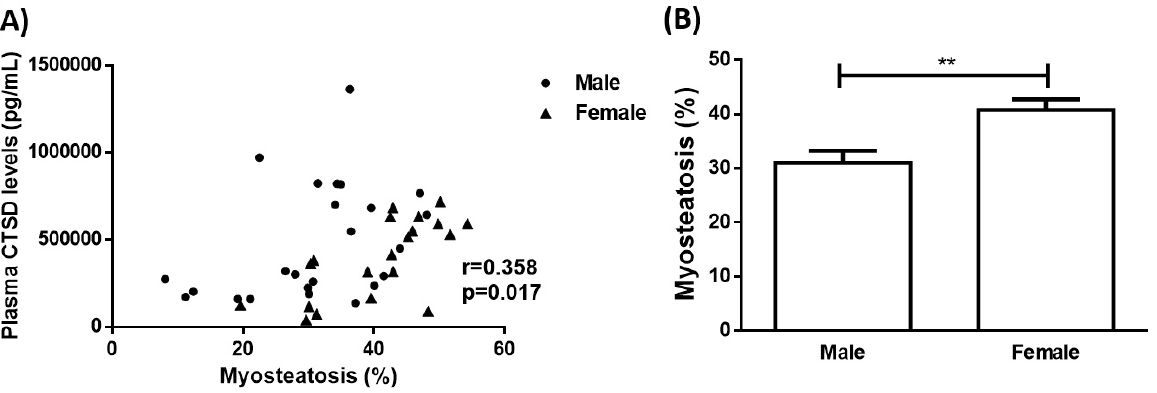
Figure 1: Myosteatosis is gender-dependent and positively correlates with plasma CTSD levels in NAFLD patients. Pearson’s correlation was performed to analyse correlation. p<0.05 is statistically significant.